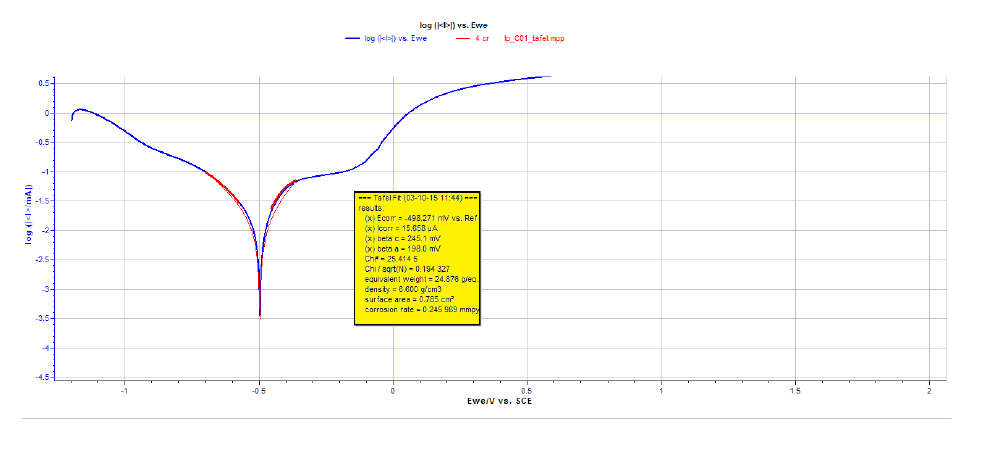
Figure 2: Tafel graph for 4% Cr specimens.